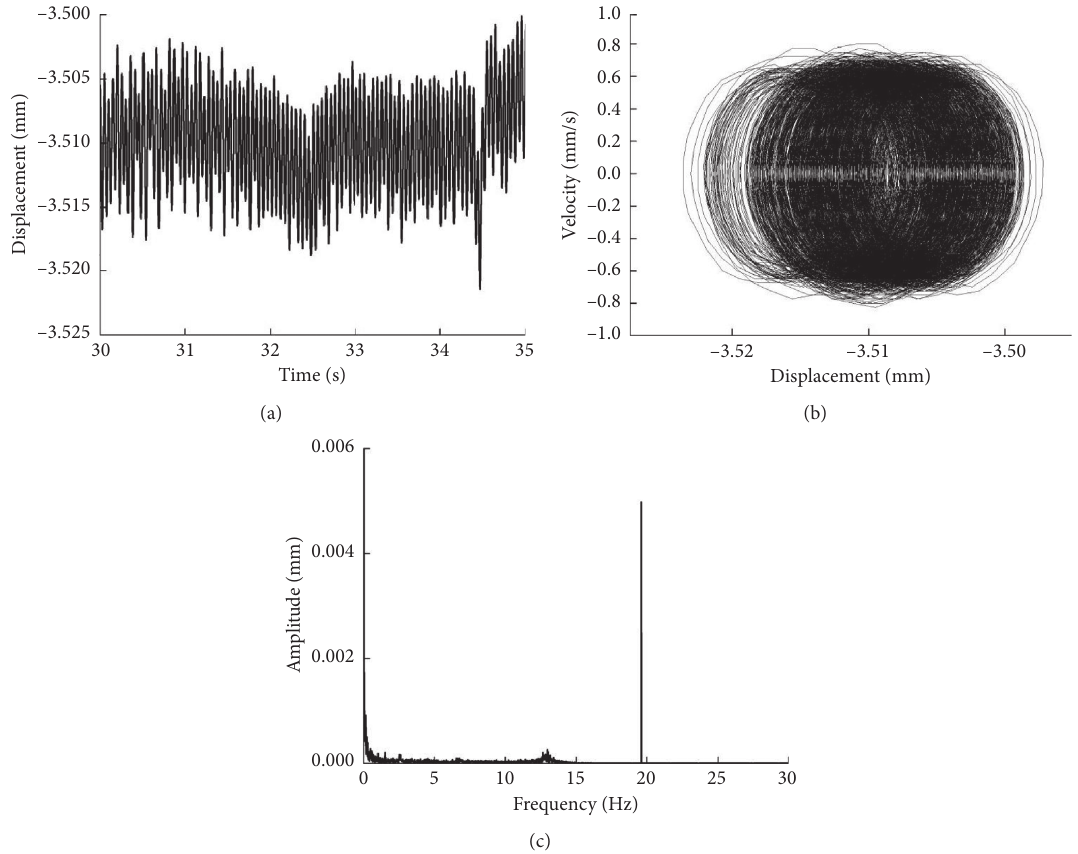
Figure 25: Chaotic motion of the system is obtained for the external excitation frequency Ω � 19 . 6 Hz: (a) waveform; (b) phase portrait; (c) amplitude